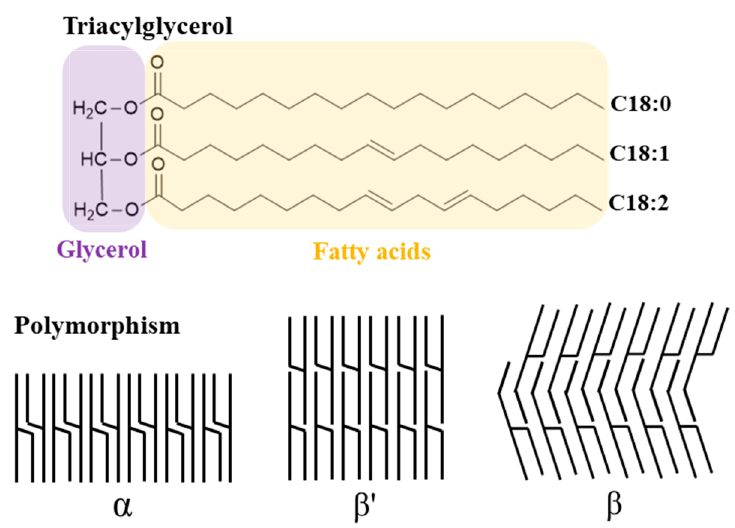
Figure 2. Schematic representation of triacylglycerol molecules and lipid polymorphism with three common types of subcellular cells, referring to the polymorphs α , β ′ , and β